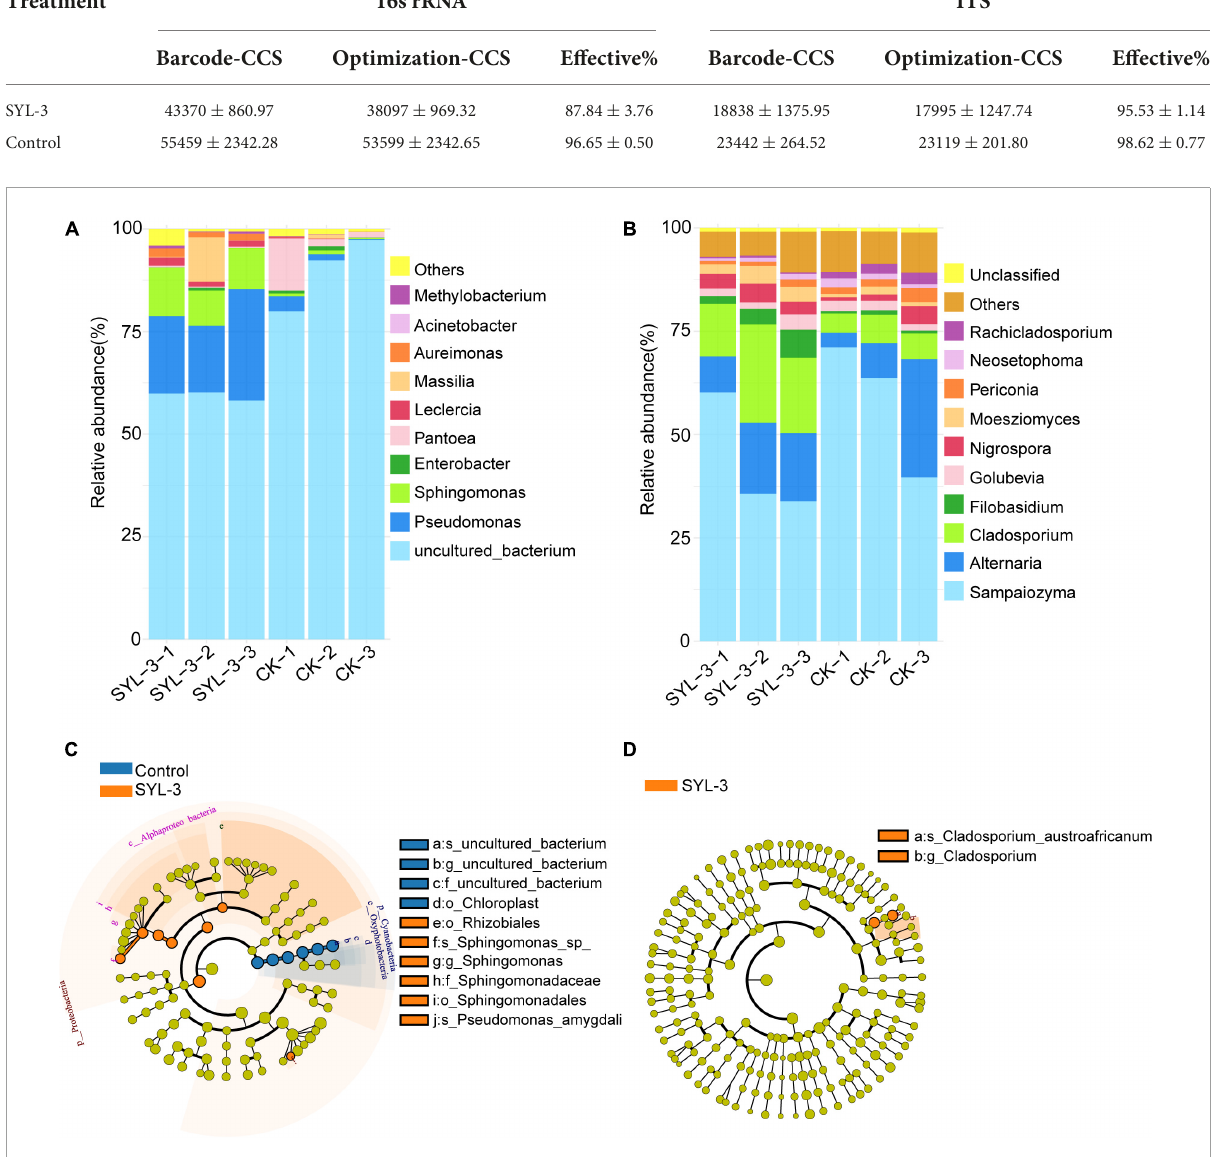
FIGURE5 Comparative analysis of the phyllosphere dominant microbial taxa in samples collected from SYL-3 and the control treatment group. Relative abundance of several dominant bacterial genera (A) and fungal genera (B) . Comparison of microbial variations based on the LEfSe analysis of bacterial community (C) and fungal community (D) in the SYL-3 treatment and control treatment. Differences are represented by the color of the taxa (orange represents the SYL-3 treatment, blue represents the control treatment, and yellow represents the species with no significant